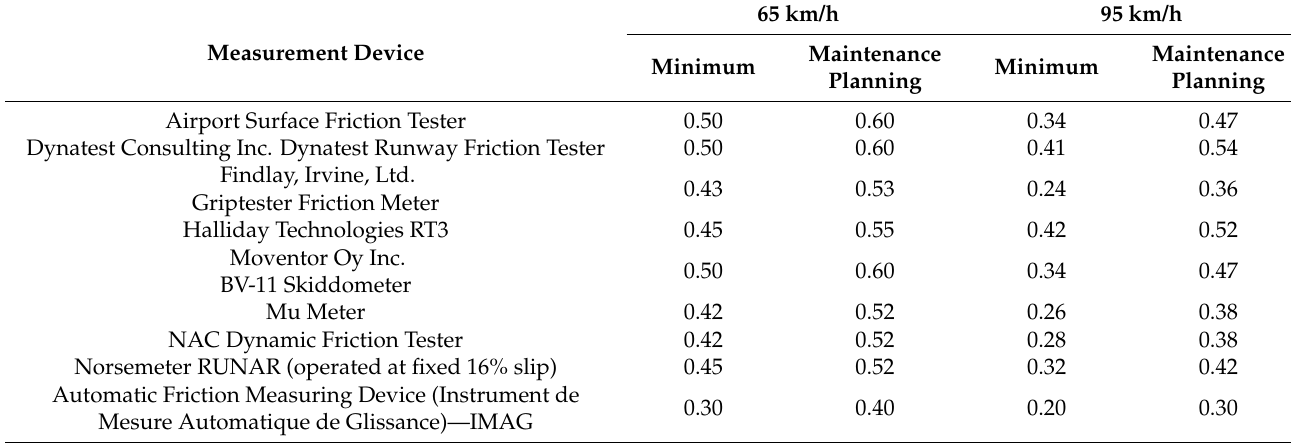
Table 3. Friction standards in order to assess the condition of a runway’s pavement for maintenance purposes.